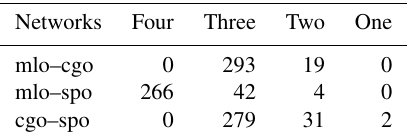
Table 1. Number of months of data available for composite differ- ences at the baseline